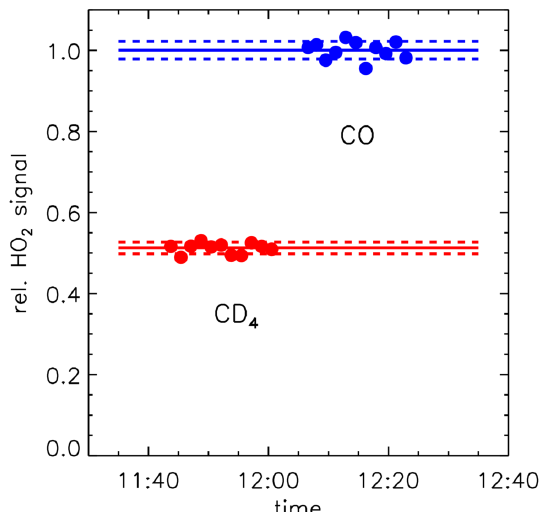
Fig. 2. Relative HO 2 signals if either CO or CD 4 is used as an OH scavenger in the calibration source. Symbols show individual measurement points, solid lines denote average values and dashed lines represent 1 σ standard deviations of